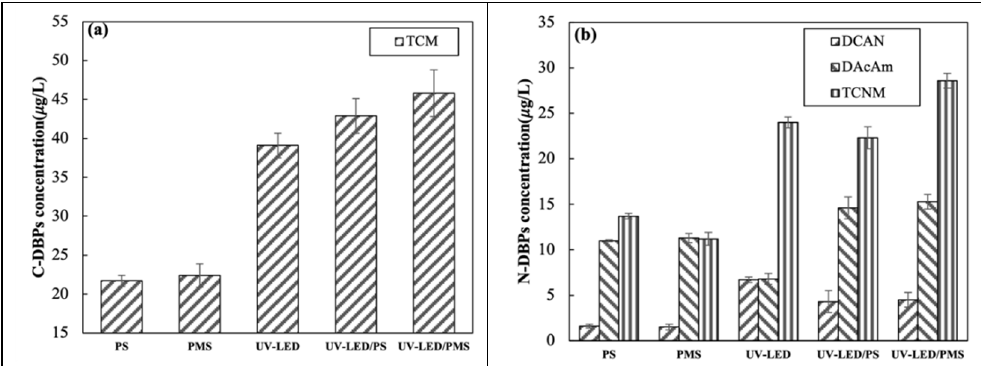
Figure 6. Formation of ( a ) C-DBPs and ( b ) N-DBPs in UV-LED, PS, PMS, UV-LED/PS, UV-LED/PMS system([CAP] 0 = 5.0 mg/L, [H 2 O 2 ] = [PS] = [PMS] = 0.5 mM, wavelength = 280 nm, pH = 7.3, lamp power I 0 = 2.4 mW/cm 2 , [NaClO] = 0.5 mM, T = 25